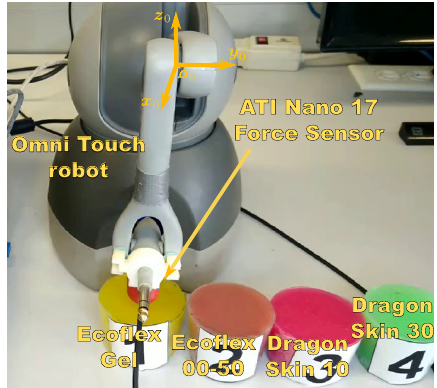
Figure 1. Experimental setup: 3D Systems Omni Touch robot, ATI Nano 17 force sensor (only for validation), and the silicone samples Ecoflex Gel , Ecoflex 00-50 , Dragon Skin 10 , and Dragon Skin 30 silicone samples.